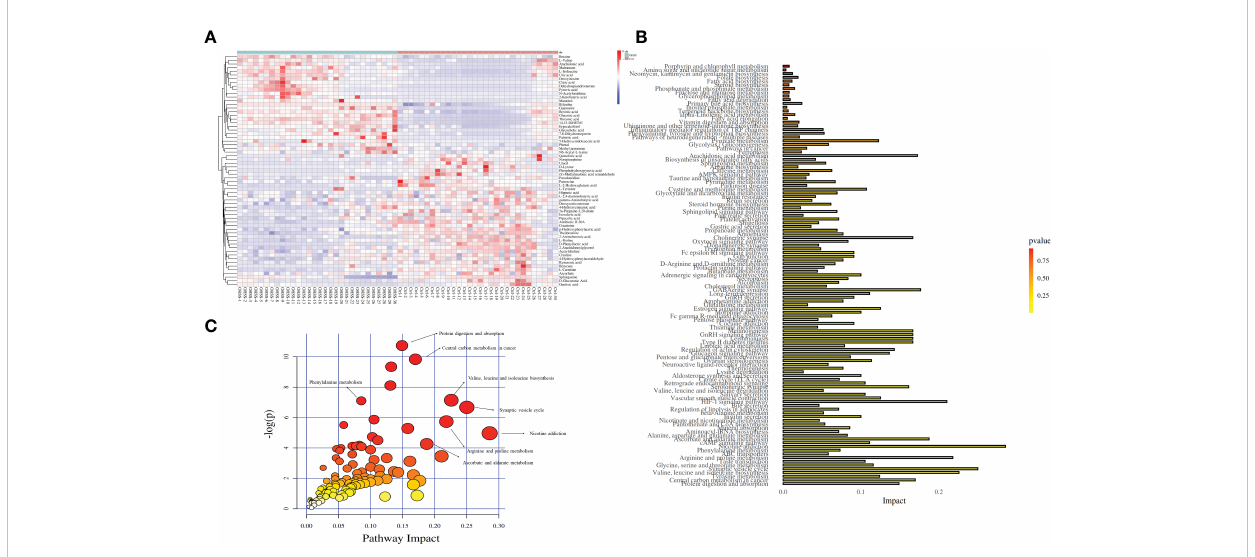
FIGURE 4 Thermogram and disturbed pathway for OHSS. (A) Thermogram for 59 differentially changed metabolites (Red: control women; blue: women with OHSS). (B) Bubble chart for disturbed pathways in OHSS, each point represents one metabolic pathway; the size of dot and shades of color are positive correlation with the impaction of metabolic pathway. (C) Histogram chart for disturbed pathways in OHSS.